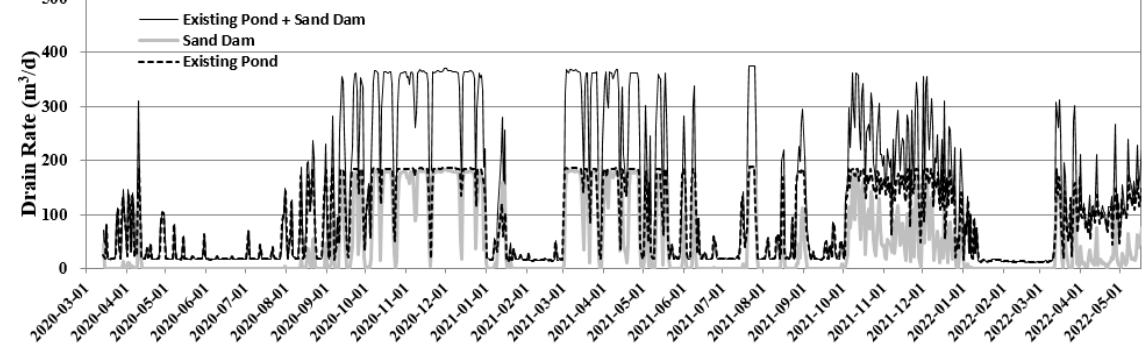
Figure 13. Water drain rates for 90% reduction in